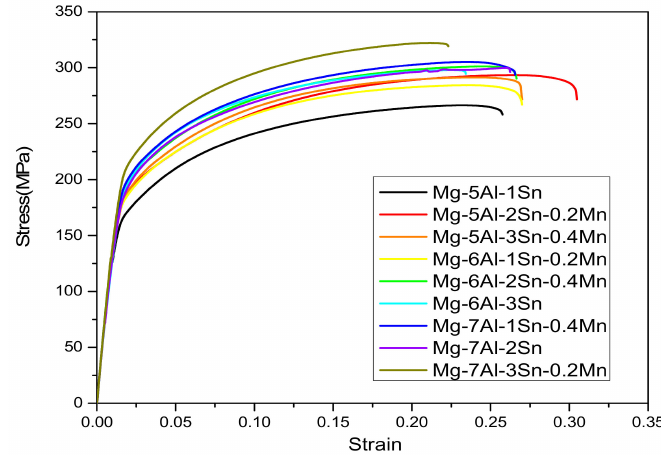
Figure 10. The stress-strain curves of the extruded Mg-Al-Sn-Mn alloy. Table 3. The result of the tensile test at room temperature of the extruded Mg-Al-Sn-Mn alloy. Number Alloy